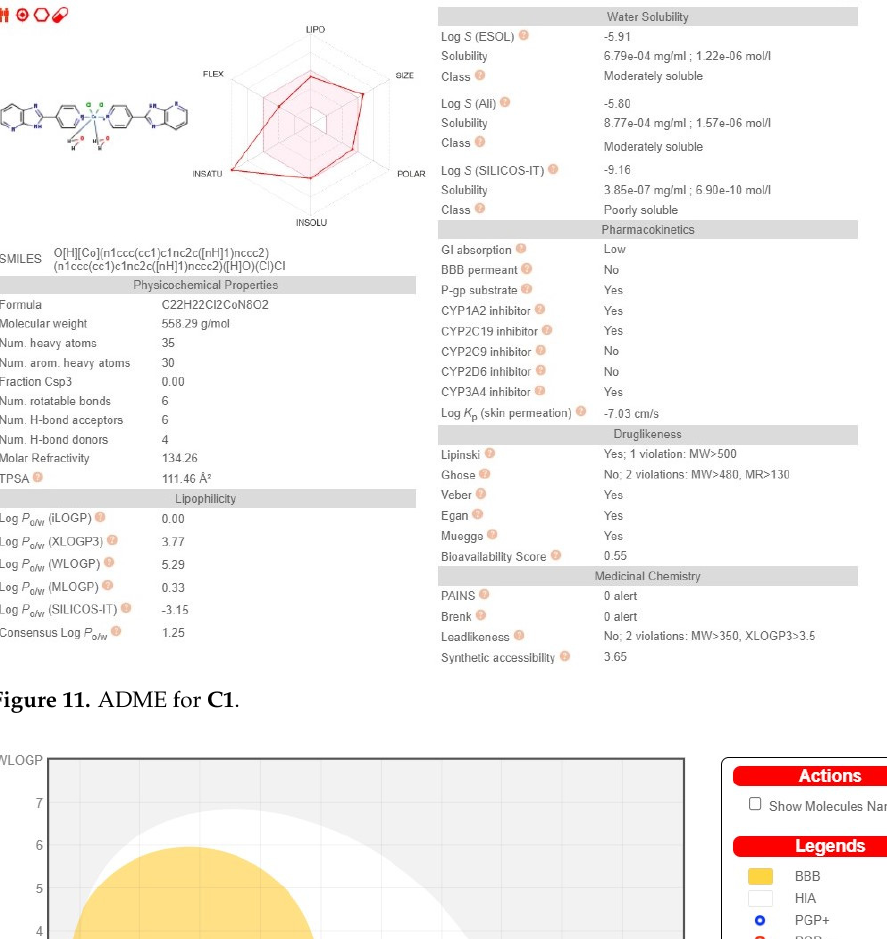
Figure 10. ADME for L4 .